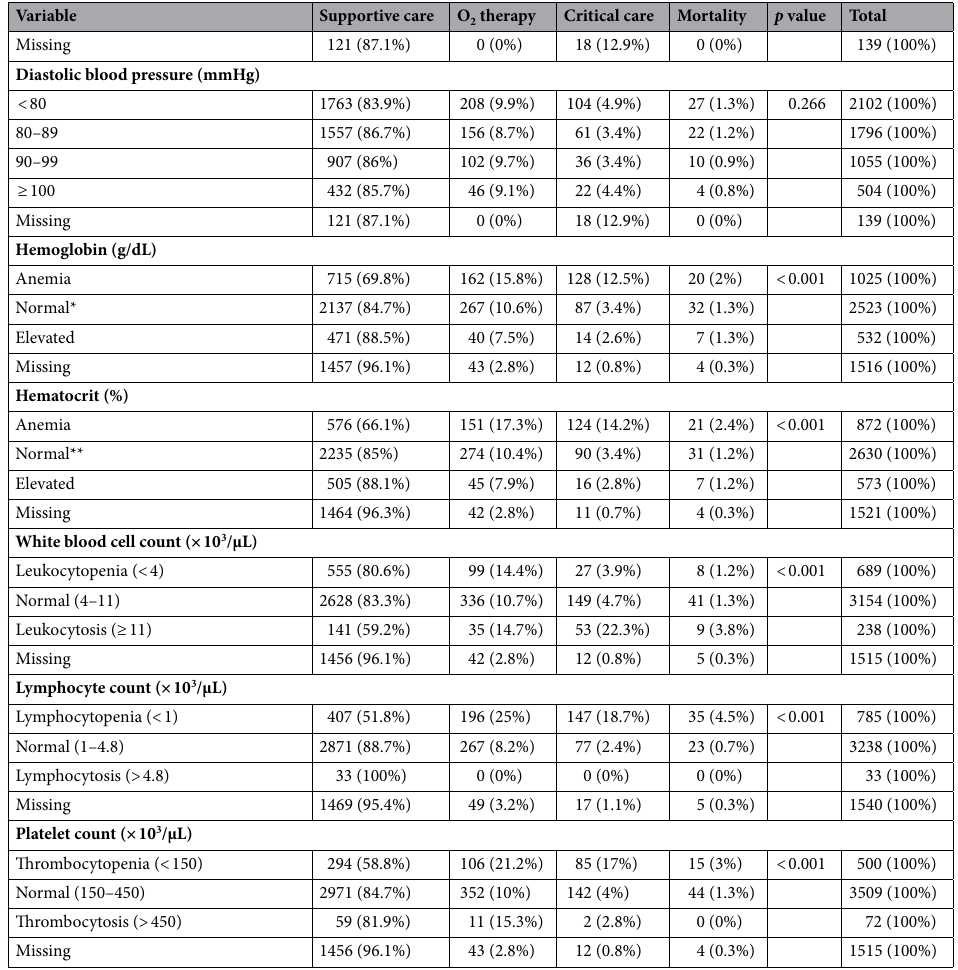
Table 1. Patient characteristics in the model development cohort by the worst severity during the disease course. Values in cells and parentheses are the number and percentage of patients, respectively, except for the days to recovery or death. Patient characteristics in the external validation cohort is summarized in Supplementary Table S2. *Male, 13.8–17.2 g/dL; Female, 12.1–15.1 g/dL. **Male, 41–50%; Female,